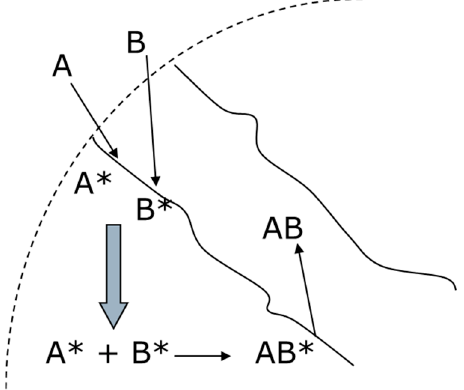
Figure 4. Schematic picture of the mechanism of heterogeneous